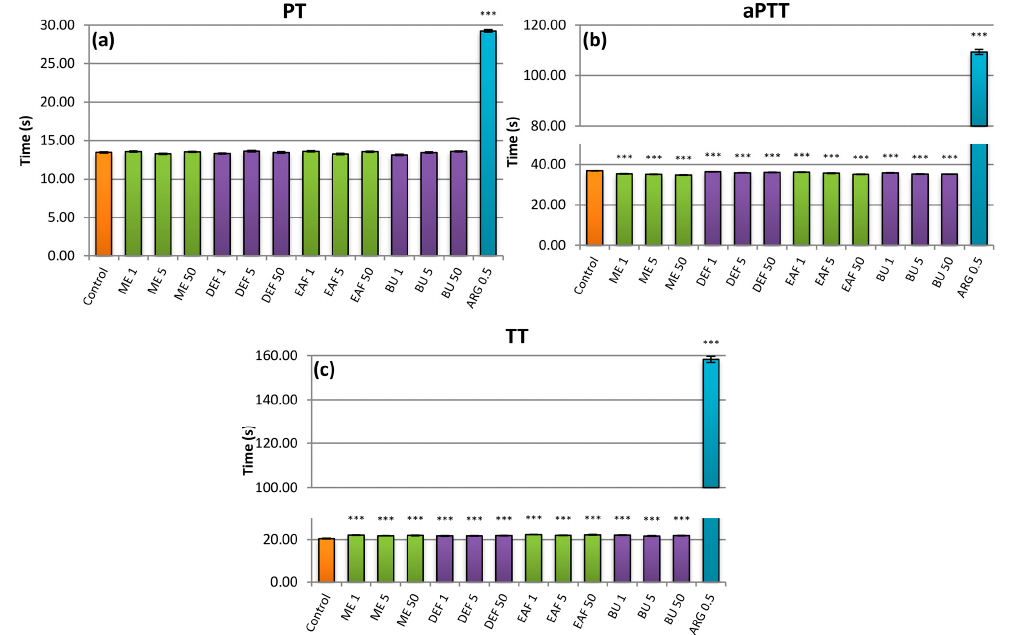
Figure 6. Effects of the investigated analytes on coagulation times: ( a ) prothrombin time (PT), ( b ) activated partial thromboplastin time (aPTT), ( c ) thrombin time (TT). Results presented as means ± SE ( n = 10–12). Statistical differences: *** p < 0.001 for control plasma versus plasma incubated with analytes. Analytes: ME—methanol extract; DEF—diethyl ether fraction; EAF—ethyl acetate fraction; BF— n -butanol fraction; ARG—argatroban; number after analyte symbol indicates concentration in µ